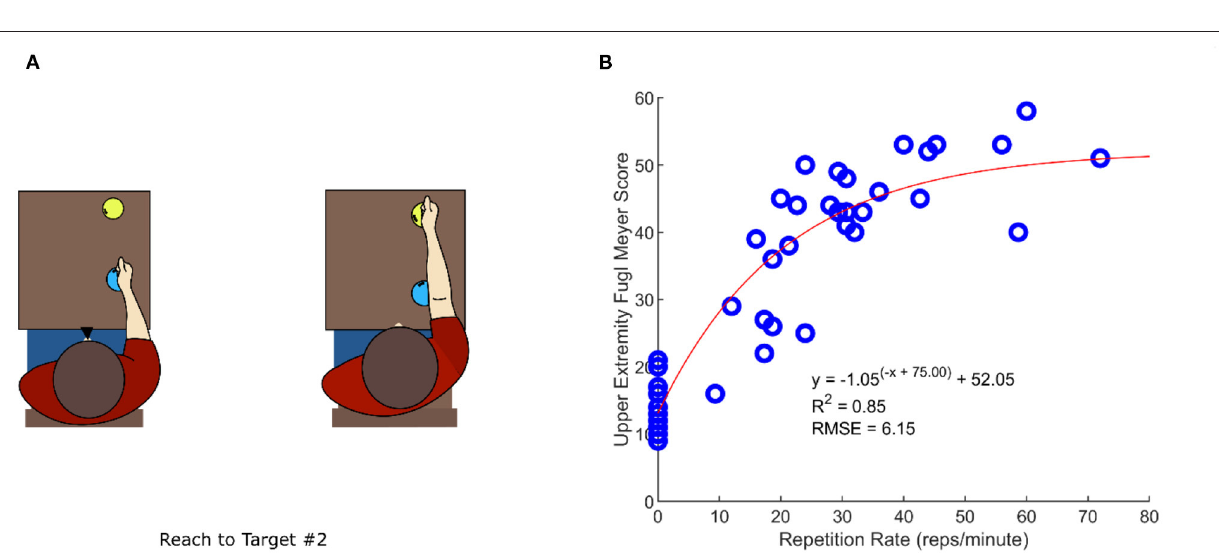
( Figure 8A ). Users with greater steadiness curvature (either decelerating or accelerating) tended to use the system less ( Figure 8 ). Thus, there was an optimal range for steadiness